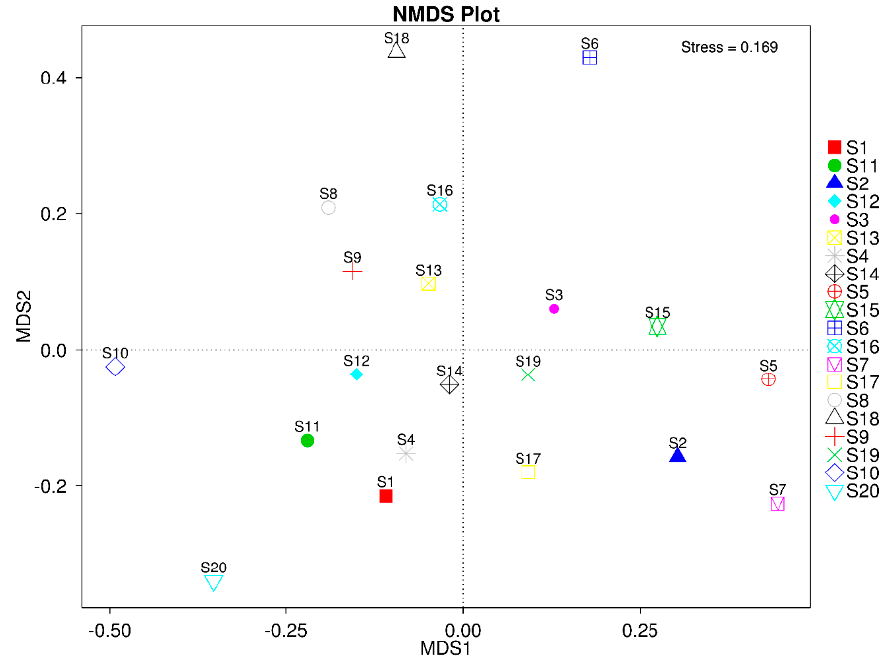
Figure 7. Non-matric multidimension scaling plot for beta diversity of microbial community struc- ture.